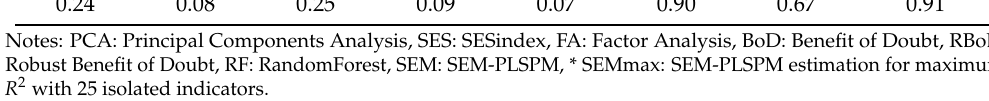
Table 7. Coefficient of determination R 2 as a function of contextual vulnerability estimation procedure.